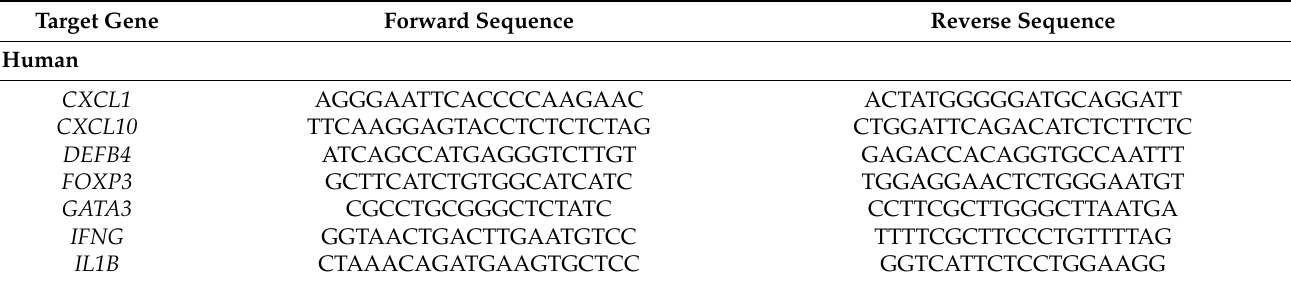
Table 2. Human and mouse primer sequences for